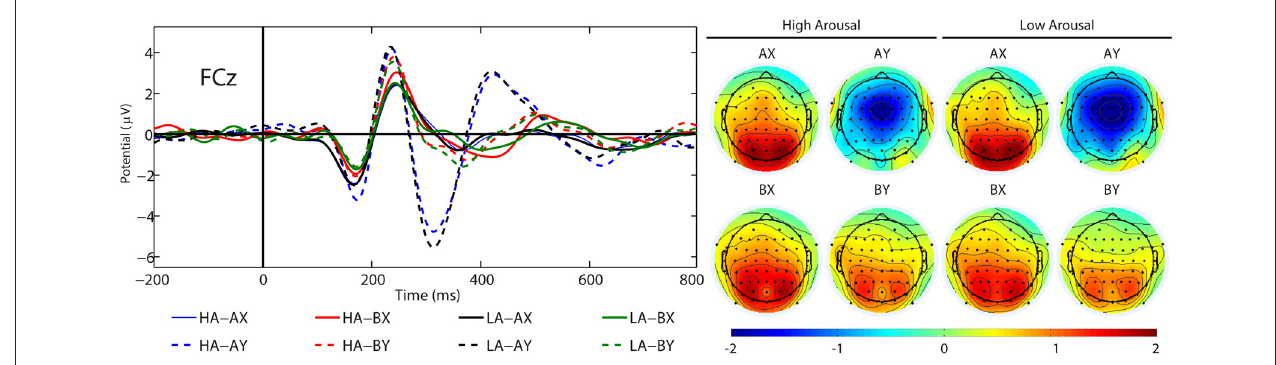
FIGURE 7 | Grand average ERPs (N2) and topographical maps elicited by the AX, AY, BX and BY sequences at FCz, separately for low (LA) and high (HA) arousal.